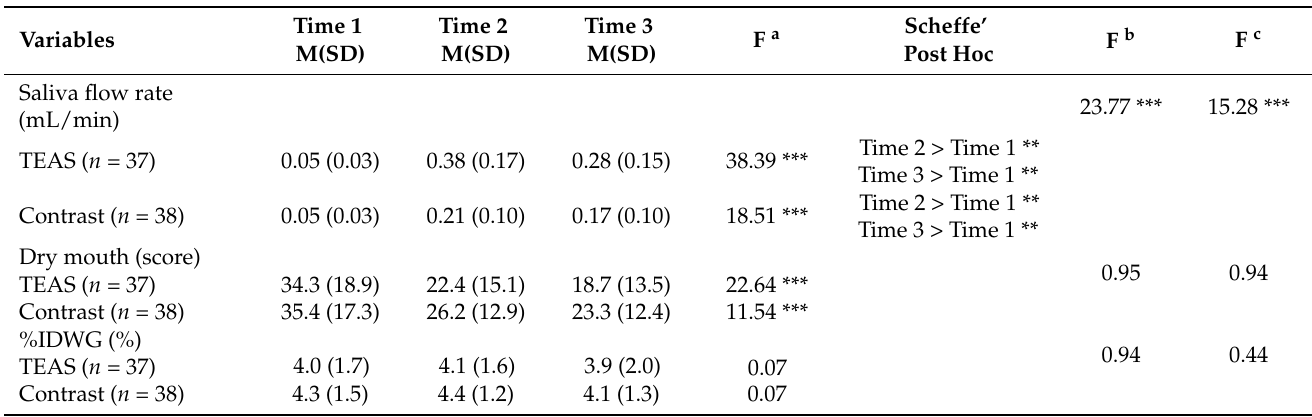
Table 2. Effect of electrical stimulation of acupoints for both groups ( n =